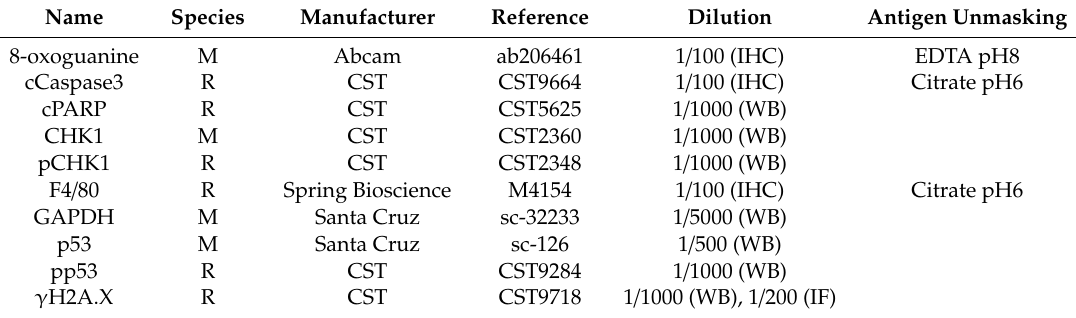
Table 1. Primary antibodies used for